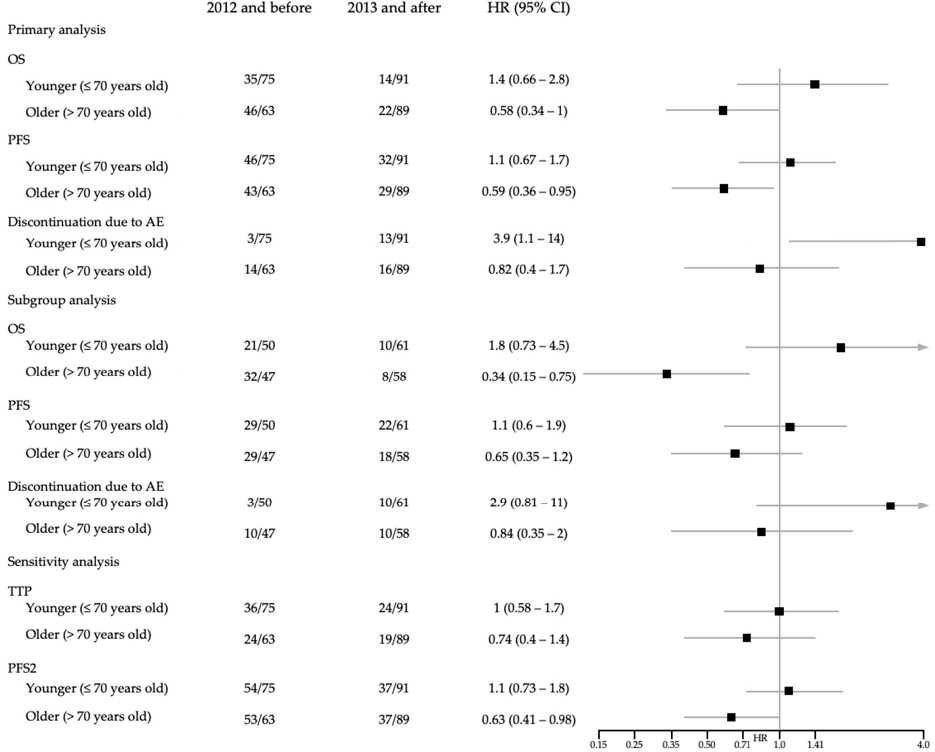
Figure A2. Hazard ratios of overall survival, progression-free survival and discontinuation due to adverse events in patients receiving first-line treatments for Waldenström macroglobulinemia in early (2006 to 2012) and modern eras of younger (70 years of age or younger at initiation of 1 L therapy) and older (older than 70 years of age at initiation of 1 L therapy) populations, in primary and sensitivity analysis settings. AE: adverse event; CI: confidence interval; HR: hazard ratio; PFS: progression free survival; PFS2: progression free survival counting all deaths after lost of follow up as events for PFS (the second setting for sensitivity analyses); OS: overall survival; TTP: time to progression (the first setting of sensitivity analyses).